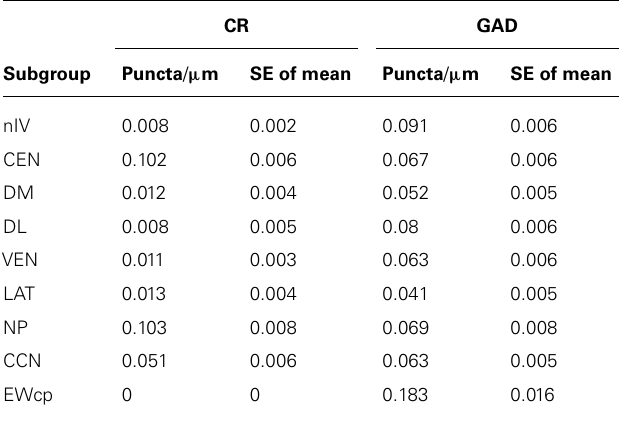
Table 3 | Quantification of calretinin and GABAergic input to nIV and nIII subgroups. CR GAD